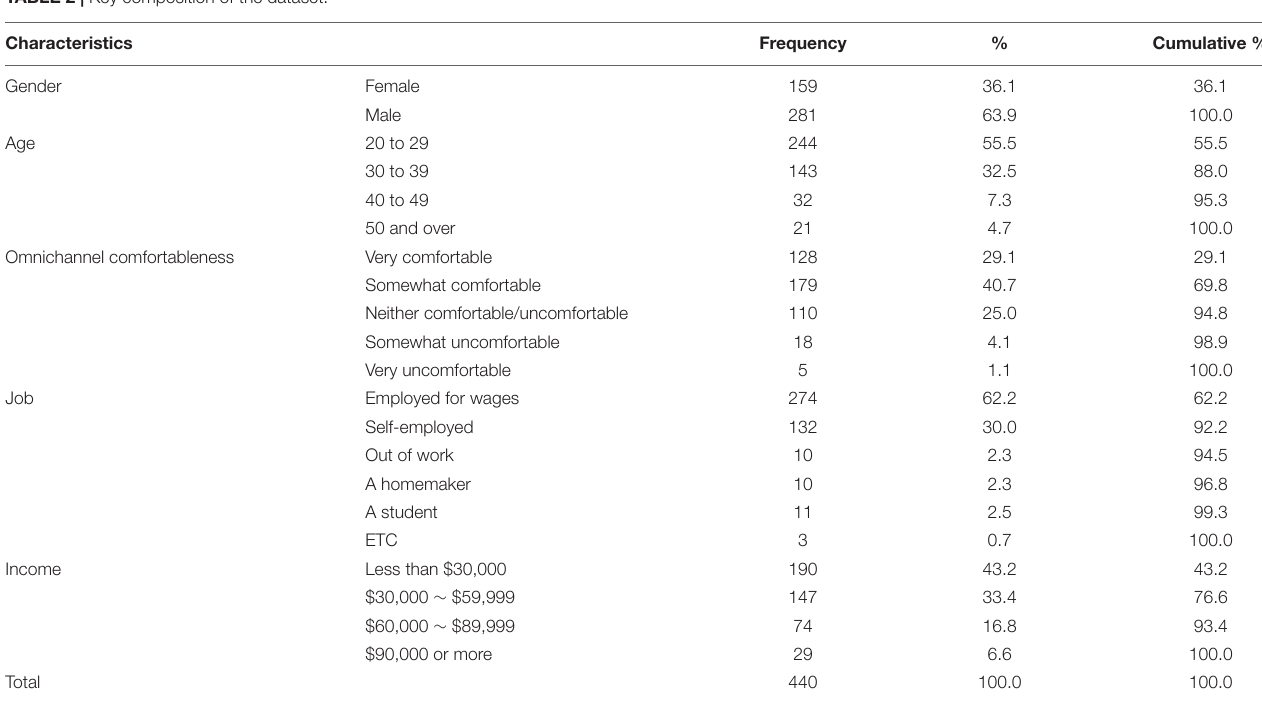
TABLE 2 | Key composition of the